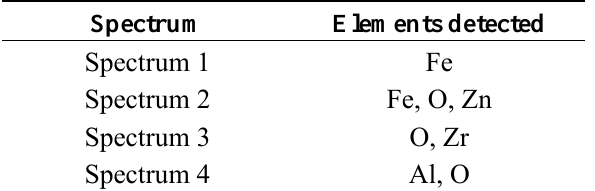
Table 2. Elements detected in Spectra 1–4 in Figure 2.